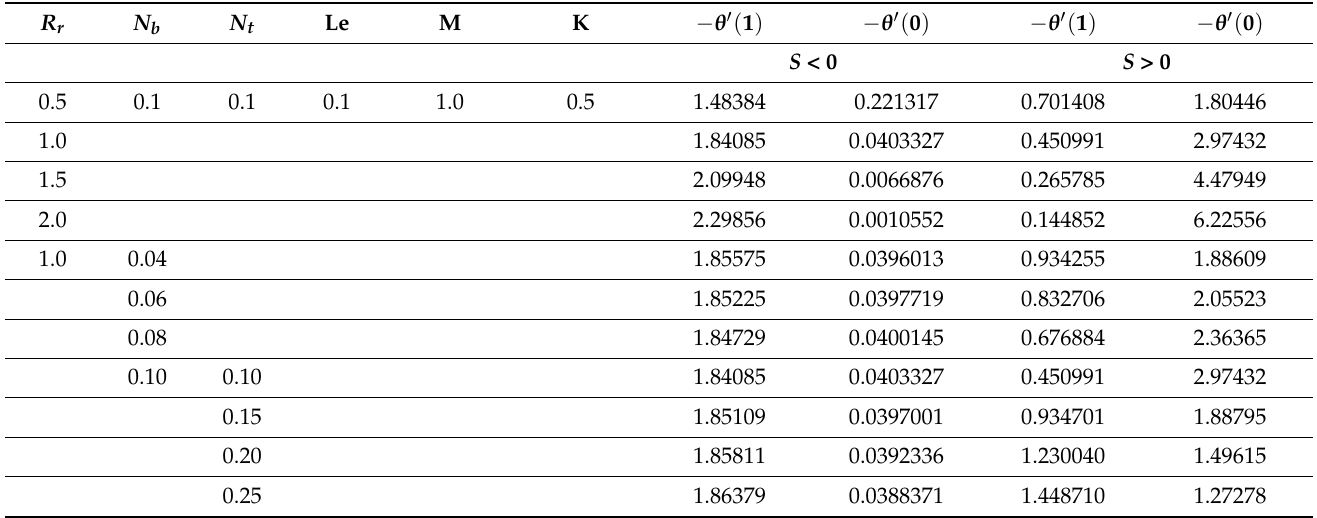
Table 6. Local Nusselt number for γ Al 2 O 3 − H 2 O at lower and upper plane with strong interaction n = 0.